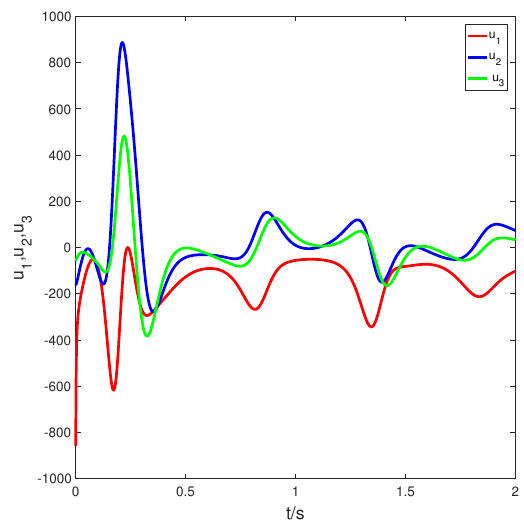
Figure 2. Switch 1 control input of error